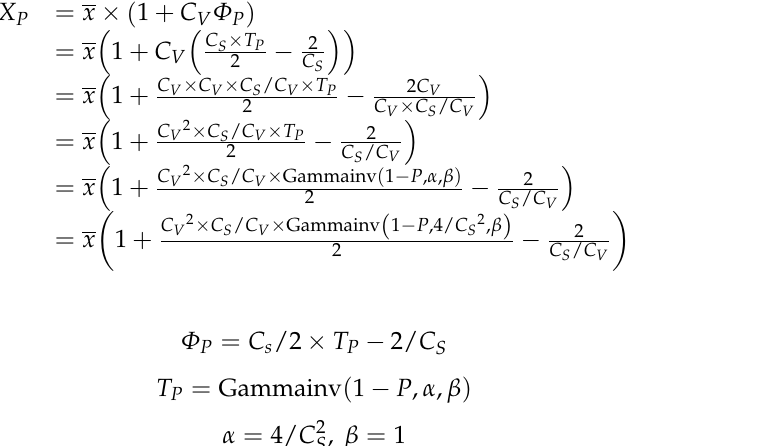
Figure 2. The runoff composition diagram of “7.21” flood at Huayuankou station.